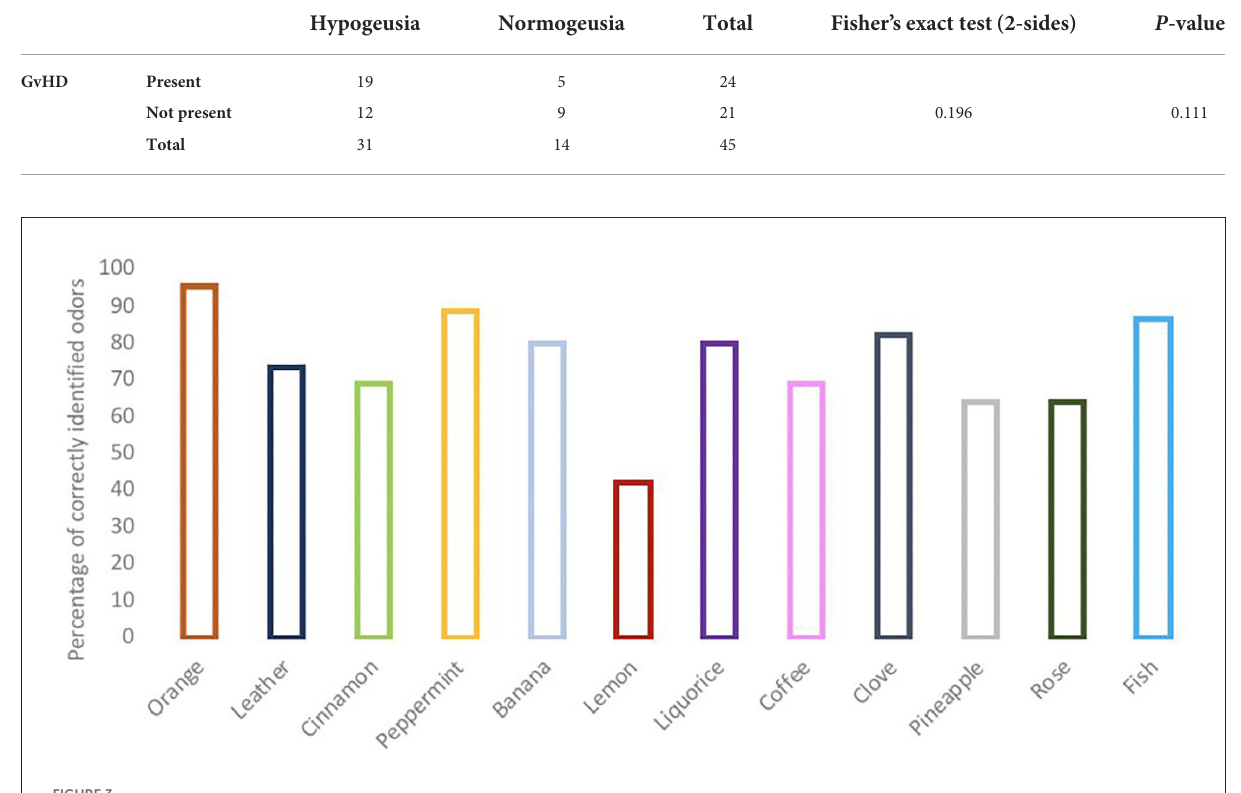
FIGURE3 Outcomes of the clinical smell evaluation test.